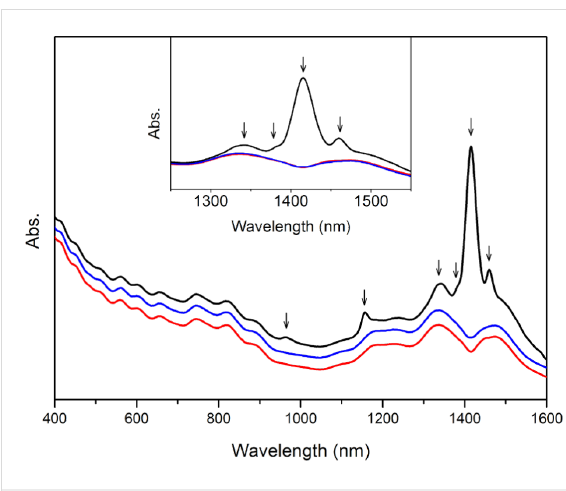
A similar spectral-subtraction method was carried out with SWNTs dispersed in [BMIM] + [BF 4 ] − and the resulting spectra are plotted in Figure 6. The agreement of the spectrum